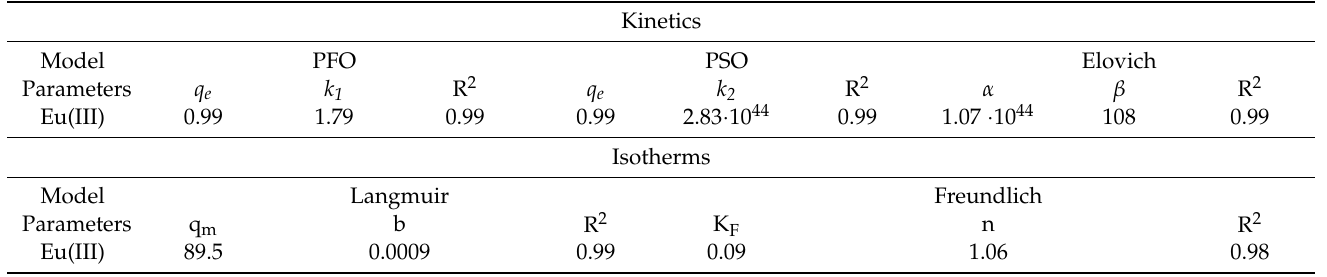
Table 1. Parameters of the kinetics and isotherm of Eu(III) sorption on A. platensis .